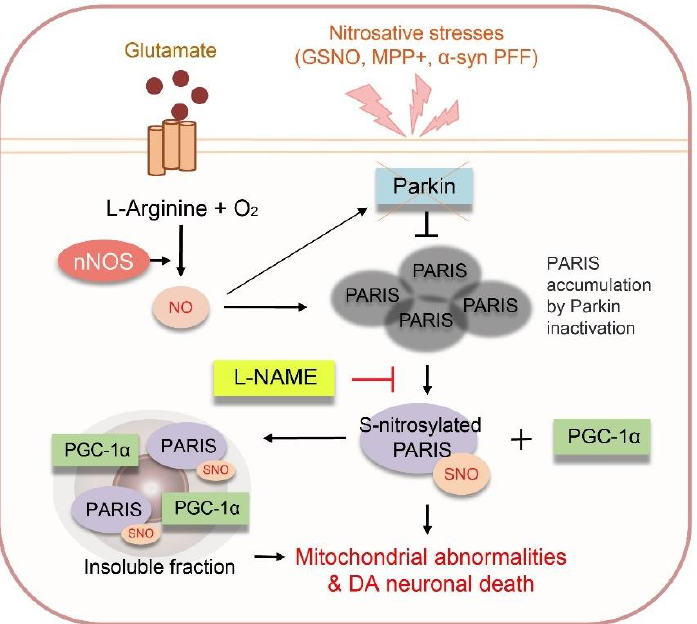
Figure 8. A proposed model of the function of the S-nitrosylated PARIS in dopaminergic neurons. PARIS can be S-nitrosylated at cysteine 265 (C265), and S-nitrosylated PARIS translocates to the insoluble fraction, leading to the sequestration of PGC-1 α into insoluble deposits. In the sporadic PD model, α -synuclein preformed fibrils ( α -syn PFFs)-injected mice, we found an increase in S-nitrosylated PARIS and insoluble sequestration of PGC- 1α in substantia nigra (SN), resulting in mitochondrial abnormailities and DA neuronal death that were restored by N( ω )-nitro-L-arginine methyl ester (L-NAME). These results suggest that modulation of NO can be a therapeutic for α -syn PFFs-mediated neurodegeneration.